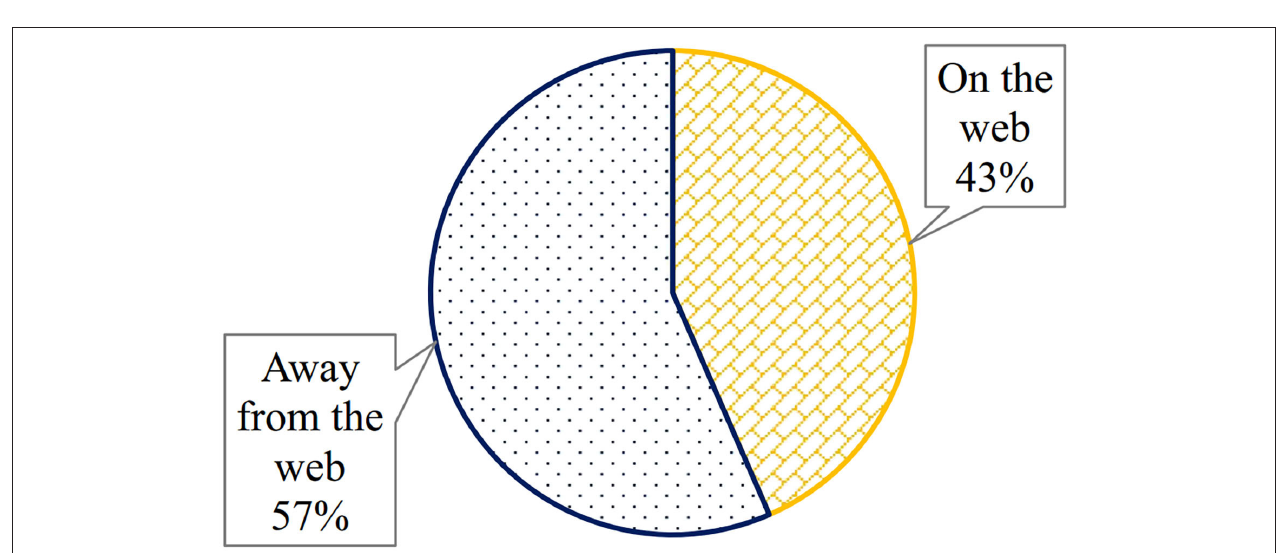
FIGURE 4 | Claimed availability of WEF nexus tools in the public